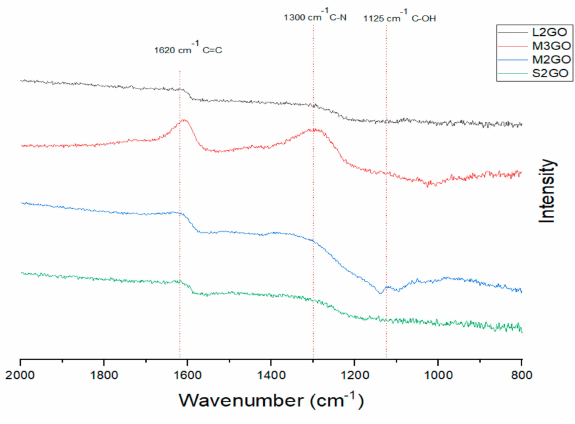
Figure 6. Collection of chosen FTIR spectra of analyzed powders of graphene oxide treated with hydrazine cross-linking, according to the labeling in Table